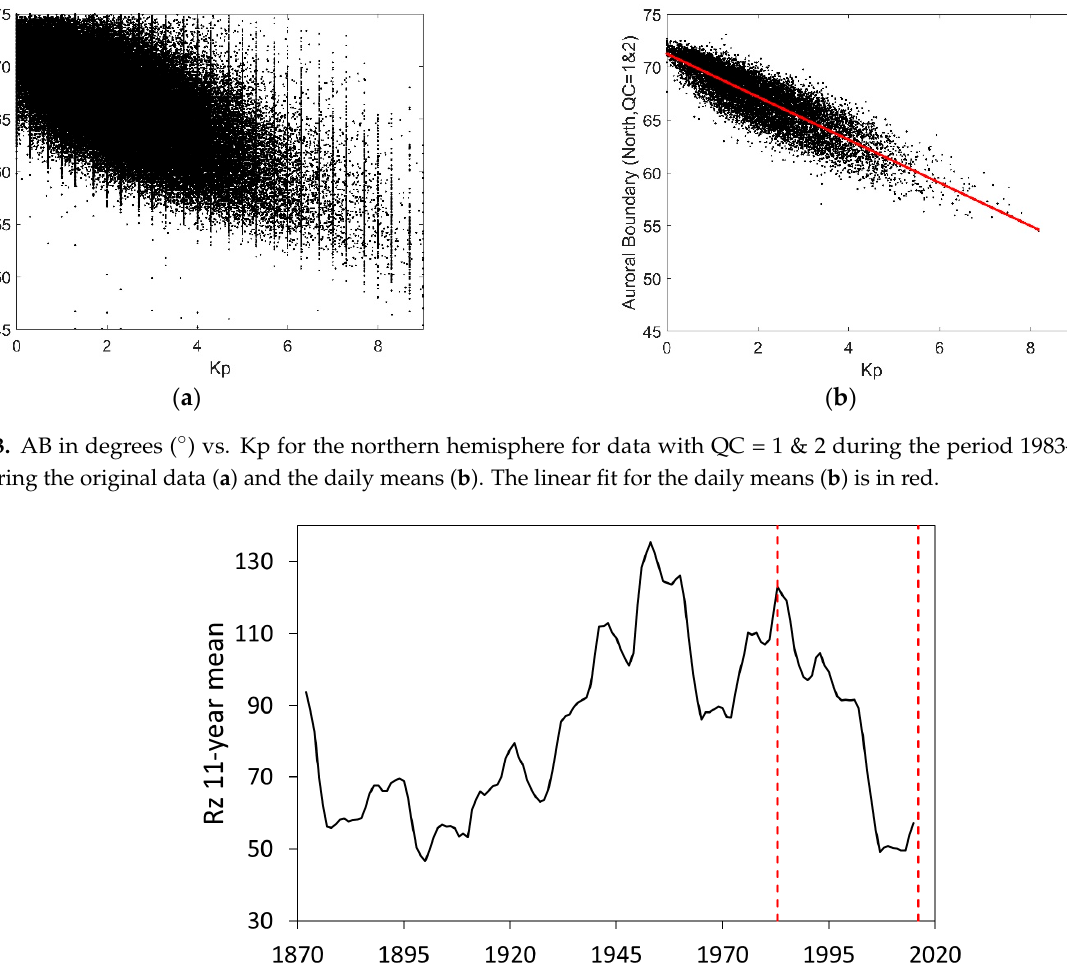
Figure 4. Sunspot number, Rz, 11-year running mean. Years 1983 and 2016 are indicated as vertical dashed red lines. Data obtained from WDC-SILSO, Royal Observatory of Belgium, Brussels (http://www.sidc.be/silso/datafiles, accessed on 17 April 2020).